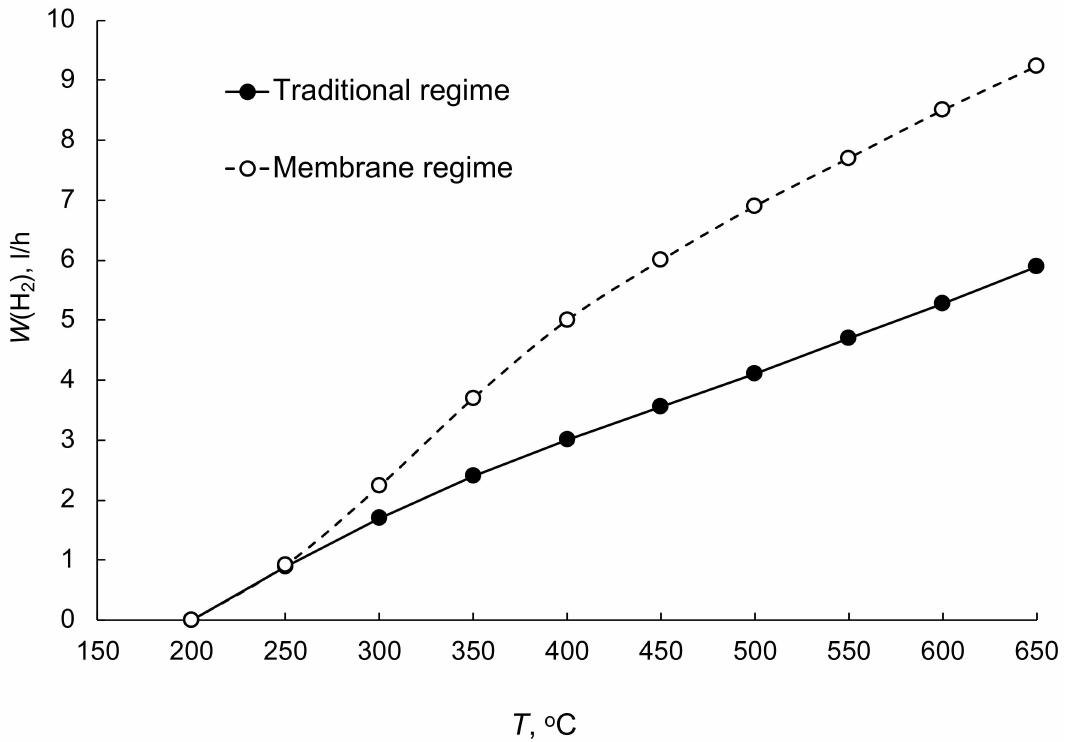
Figure 11. Comparison of the temperature dependences of ethanol steam reforming accompanied by ultrapure hydrogen extraction from the reaction zone (membrane process) and without extraction (traditional